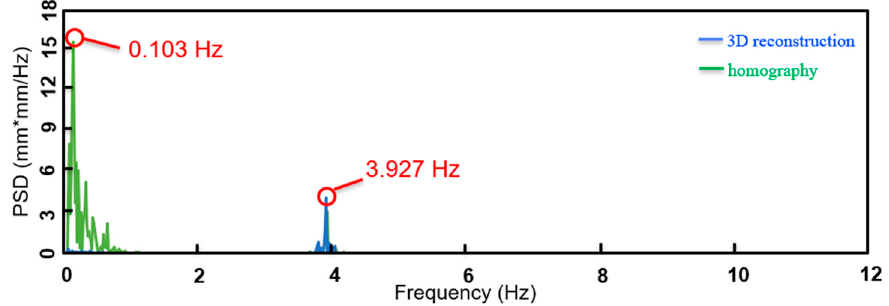
Figure 17. Comparison of PSD from 3D reconstruction and homography methods ( Z w = 1000).